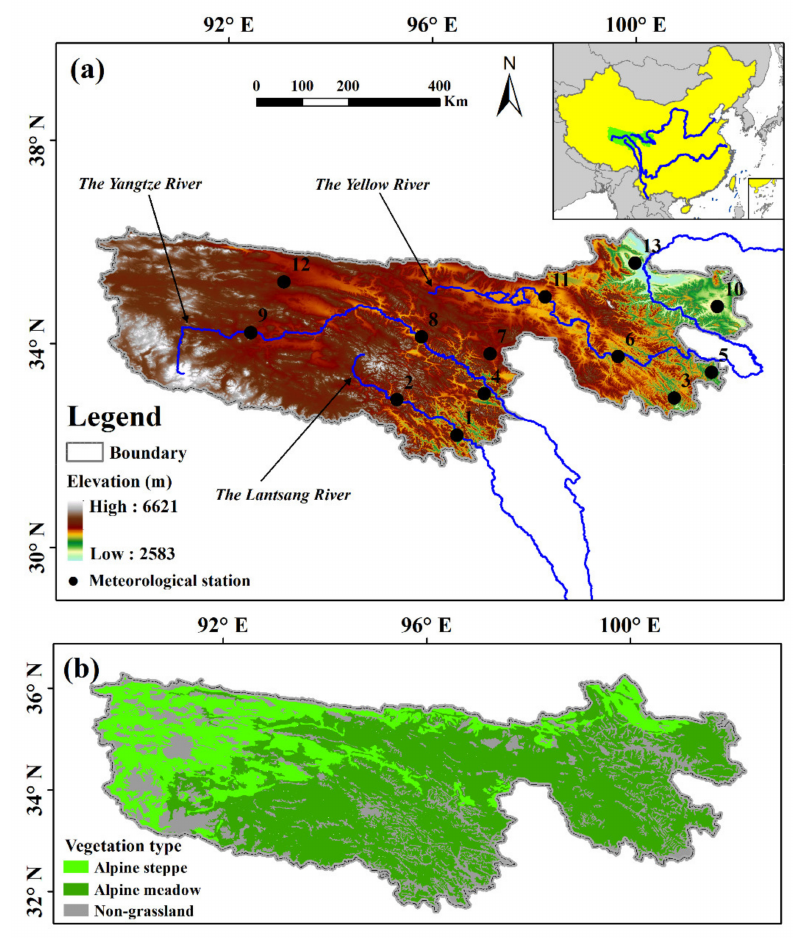
Figure 1. Location of the Three-River Source Region (TRSR) in China ( a ). The main map presents the digital elevation model (DEM) of the TRSR. The black circle denotes the meteorological station. The grassland type of the TRSR is shown in ( b ), and the light and dark green regions denote the alpine steppe and meadow, respectively. The non-grassland types are masked by gray